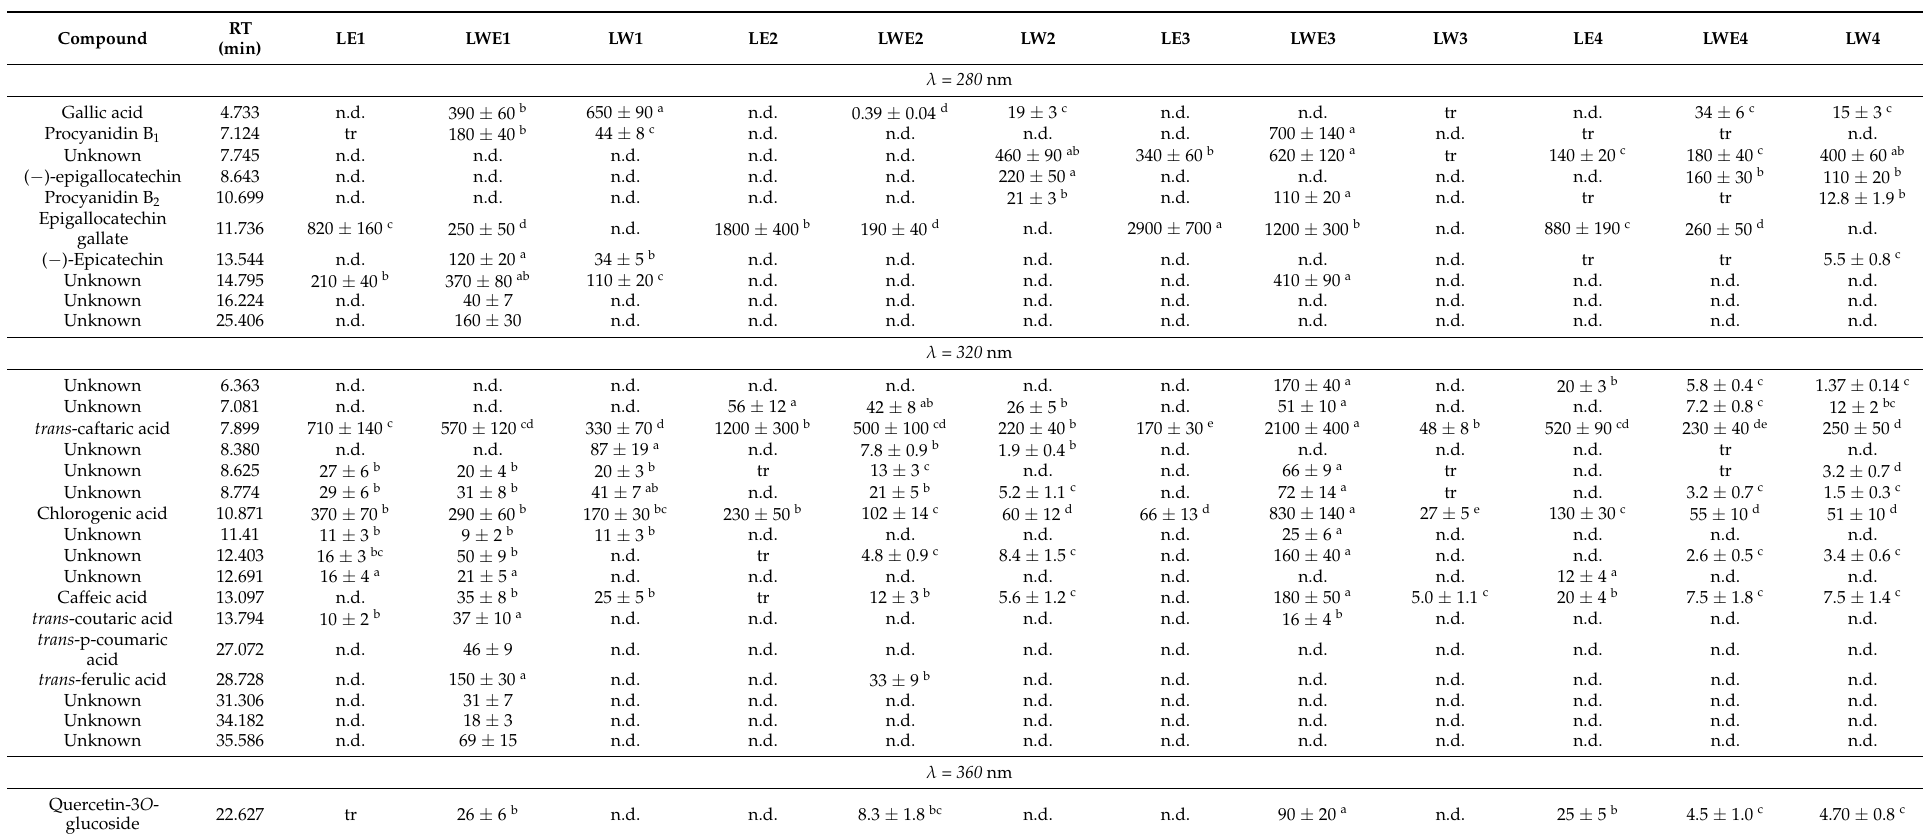
Table 2. Content (expressed in mg g − 1 ) of the identified polyphenols into the wine lees